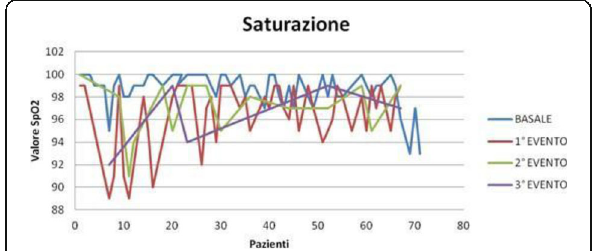
Fig. 4 (abstract A167). See text for description